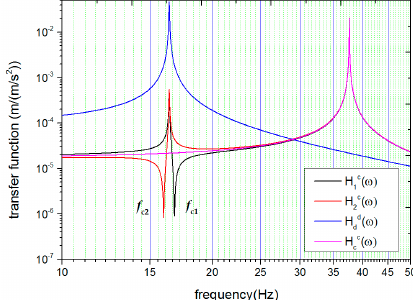
Figure 1. Four calculated frequency response functions: the displacements of individual test mass upon platform acceleration (cid:12) H c 1 ( ω ) (cid:12) and (cid:12) H c 2 ( ω ) (cid:12) when the damping coefficient is assumed to be 0.001 N/(m/s) and the mismatch of stiffness is 5%, the common-mode displacement | H c c ( ω ) | and (cid:12) (cid:12) (cid:12) (cid:12) d ( ω ) differential-mode displacement (cid:12) H (cid:12) when all of the parameters are ideally matched. Characteristic d (cid:12) (cid:12) (cid:12) (cid:12) frequencies f c 1 and f c 2 will appear in (cid:12) H c 1 ( ω ) (cid:12) and (cid:12) H c 2 ( ω ) (cid:12) when stiffness is mismatched.